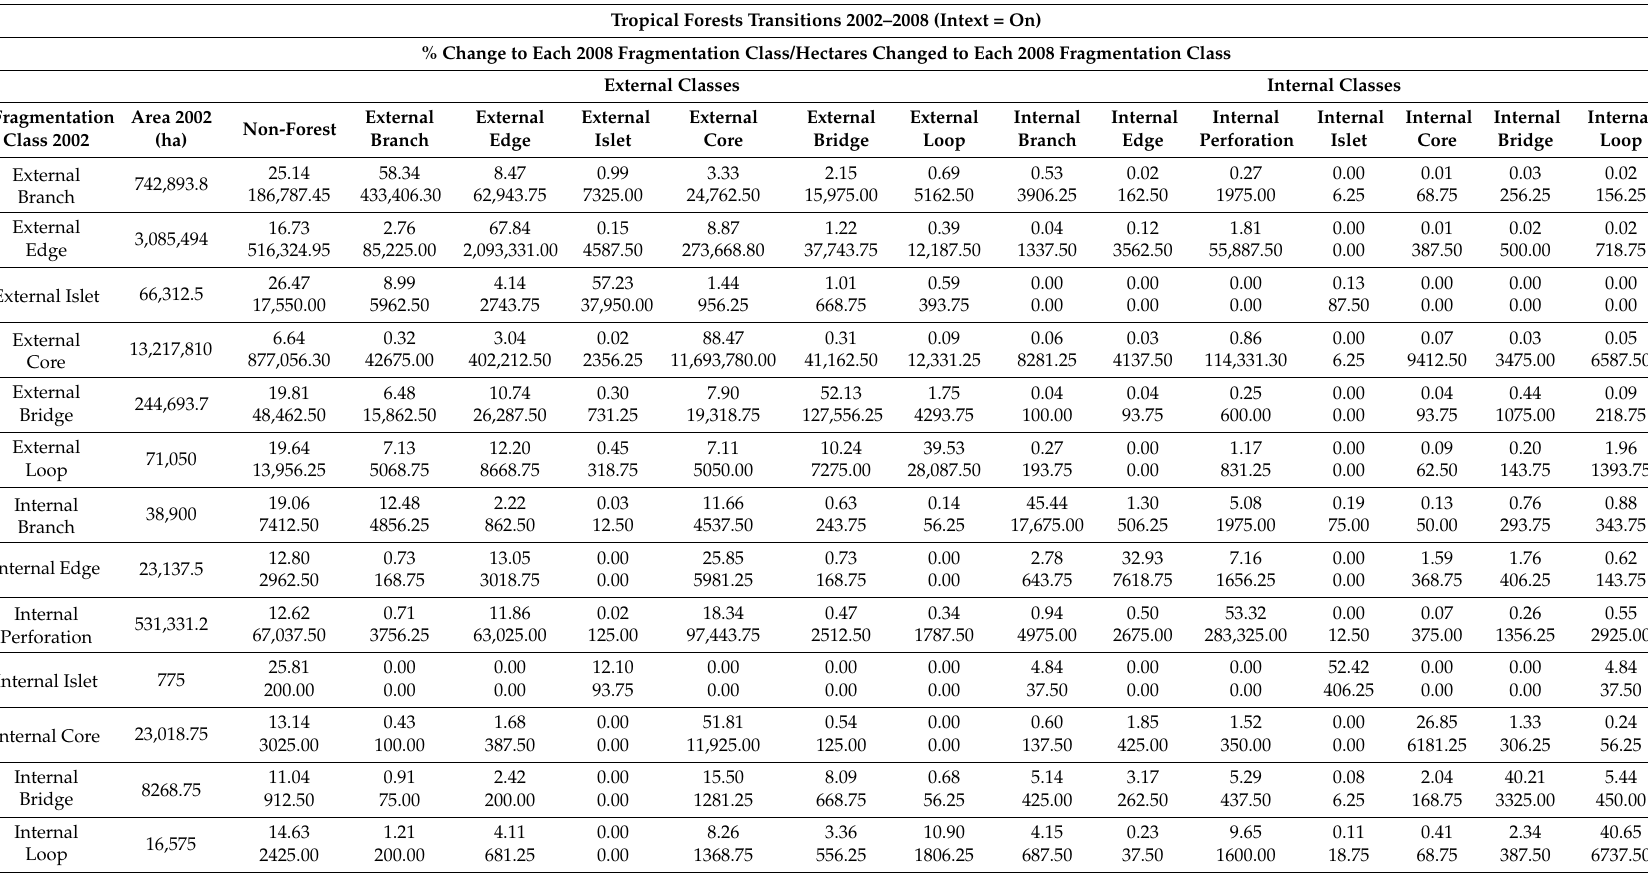
Table D1. Fragmentation classes transition matrix tropical forests in the 2002–2008 period differentiating between internal and external fragmentation classes. Tropical Forests Transitions 2002–2008 (Intext = On) % Change to Each 2008 Fragmentation Class/Hectares Changed to Each 2008 Fragmentation